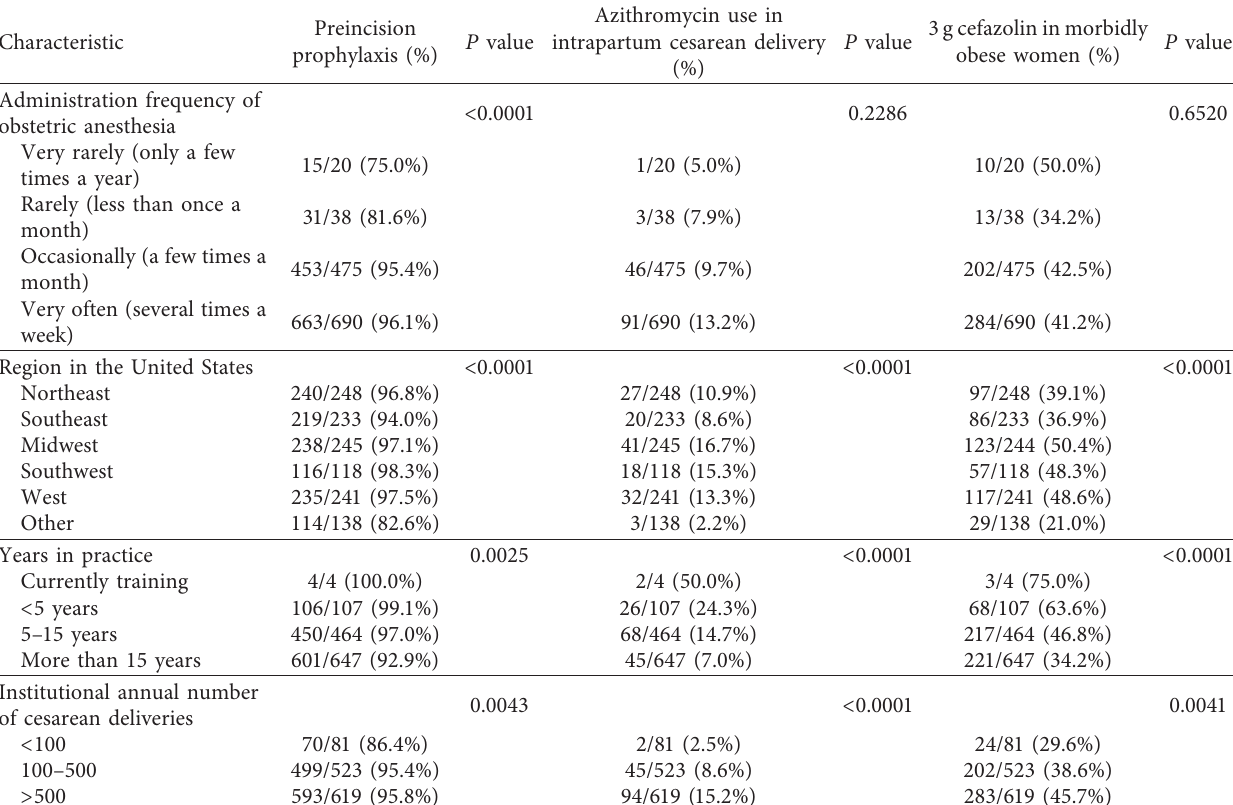
Table 3: Bivariate analysis of preincision antibiotic prophylaxis, adjunctive azithromycin for unscheduled cesarean delivery, and 3g cefazolin in morbidly obese